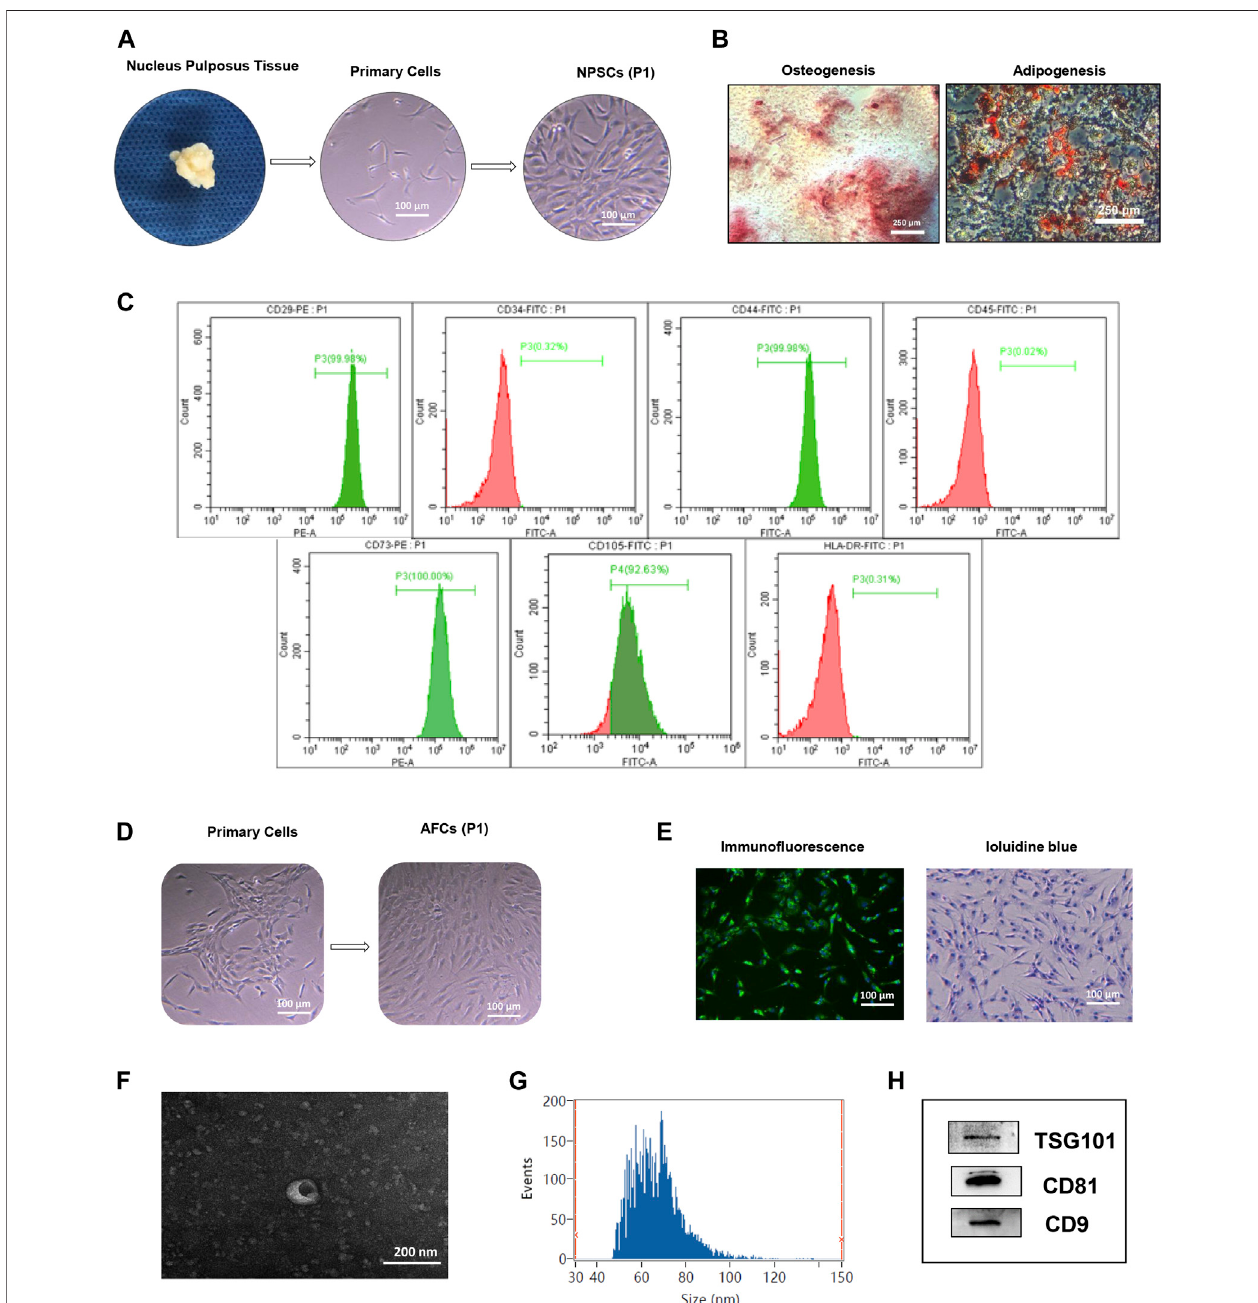
FIGURE1| Identi fi cationofnucleuspulposusstemcells(NPSCs),annulus fi brosuscells(AFCs),andNPSC-exo. (A) ProcessofisolationandcultureofNPSCsfrom nucleus pulposus tissue. Cultured NPSCs at passage 1 (P1) were spindle shaped. (B) Differentiation potential of osteogenesis and adipogenesis of NPSCs was con fi rmedbyAlizarinredstainingandOilredOstainingafter2 weeksafter invitro induction,respectively. (C) Identi fi cationofsurfacemakersofNPSCsindicatedthatthe harvested NPSCs were positive expressions for CD29, CD44, CD73, and CD105 makers, and were negative expressions for CD34, CD45, and HLA-DR makers. (D) The cell morphology of cultured AFCs at passage 1 (P1) displayed long fusiform or polygonal shaped. (E) Immuno fl uorescence staining indicated that AFCs expressedtypeIIcollagenandtoluidinebluestainingshowedAFCswerepurpleandexhibitedmetachromaticgranules. (F) Thetypicalsaucer-likemorphologyofNPSC- exo was captured by transmission electron microscopy. (G) Particle size of NPSC-exo was characterized by fl ow nano analysis. (H) NPSC-exo were positive expressions for exosomal surface markers TSG101, CD81, and CD9 by Western blotting.